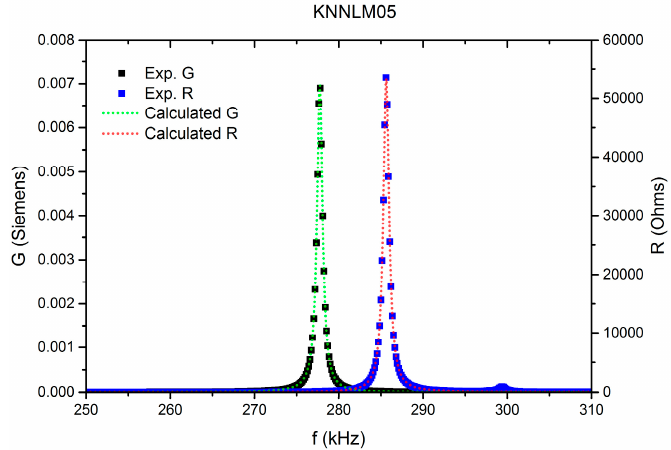
Figure 11. Planar resonance spectra for KNNLM05.